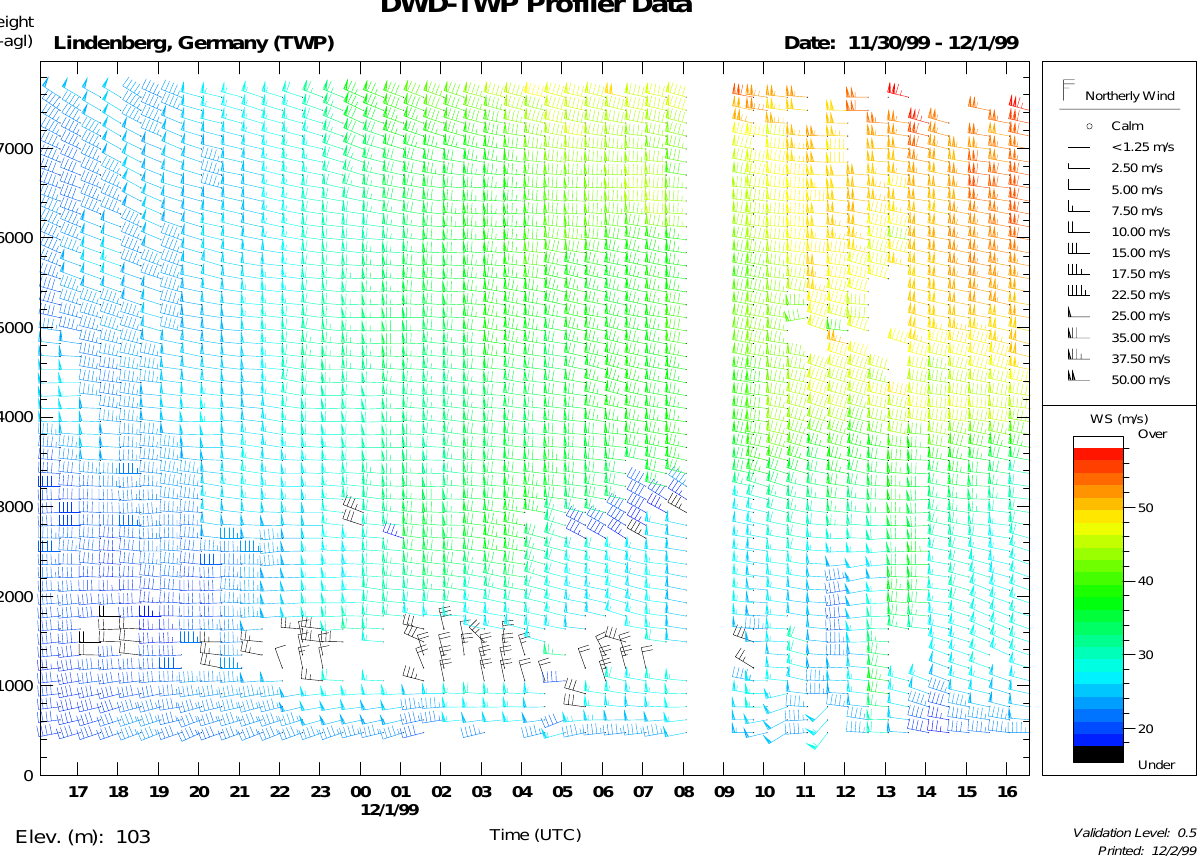
Fig. 2. The figure shows the final result of the measurement with the 482 MHz RWP at Lindenberg (Germany) on the 30 November and 1 December 1999. The wind barbs are color-coded according to the wind speed. Note the effects of the persistent ground clutter around the 1500 m and 3000 m heights. The gap in the data was caused by this detailed investigation, as the radar was programmed to store time series data for about 30 minutes, only in the East beam, thus, no wind computations were possible for that period of time.